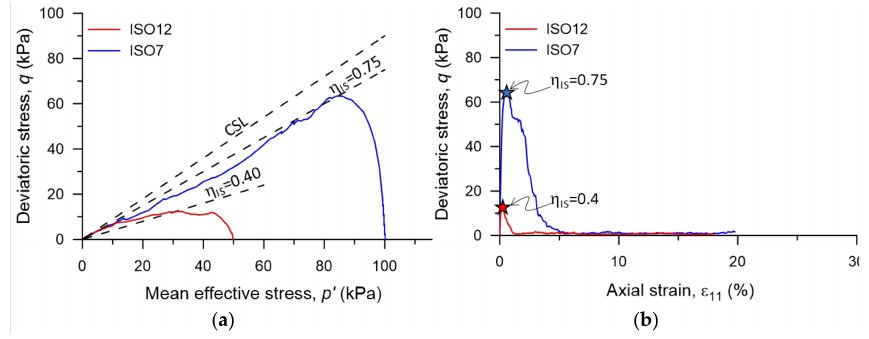
Figure 6. The simulations exhibit flow liquefaction in the ( a ) q - p (cid:48) and ( b ) q - ε 11